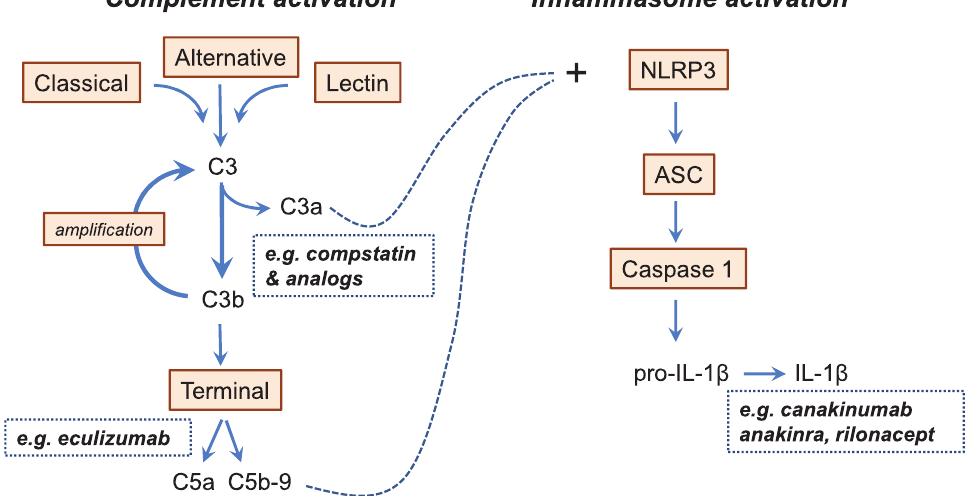
Figure 2. Relevant aspects of complement activation and inflammasome activation with their possible interconnection. The inflammasome and the complement system can be activated via so-called danger-associated molecular patterns (DAMPS) and pathogen- associated molecular patterns (PAMPS). Activation of the classical, the lectin, and the alternative pathway of complement activation all result in the activation of complement C3. The alternative pathway functions as an amplification route for all pathways of complement activation. Activation of C3 leads to the generation of C3a and the activation of the terminal effector pathway. Activation of the NOD-like receptor family Pyrin domains-containing protein 3 (NLRP3) inflammasome includes the formation of a cytosolic multiprotein complex that activates caspase 1. Caspase 1 cleaves pro-interleukin (IL)-1 β into IL-1 β . Pharmacological compounds that are used to dampen the effects of inflammasome activation primarily act at the level of IL-1 β . In the dotted squares, we have indicated some selected drugs that are already used to target complement and/or inflammasome activation in other diseases. Compstatin inhibits complement activation by binding C3 and interfering with convertase formation and C3 cleavage 90 ; eculizumab binds to complement protein C5, thus inhibiting the formation of C5a and the terminal complement complex C5b-9 85 . Canakinumab (a neutralizing monoclonal anti-IL-1 β ), anakinra (an IL-1 receptor antagonist), and rilonacept (a soluble decoy IL-1 receptor) all block the IL-1 β effector pathways of inflammasome activation 56 . The intermittent lines indicate the emerging link between activated complement and the NLRP3 inflammasome 91 . Abbreviations: ASC, apoptosis-associated speck-like protein containing a